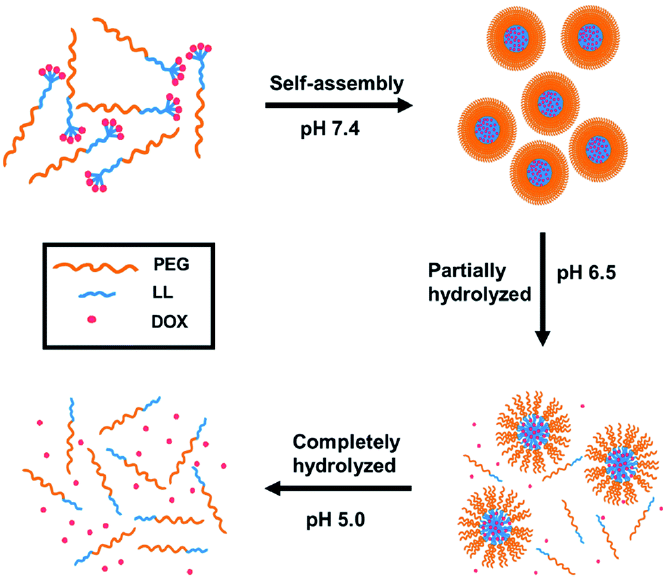
Figure 9. Schematic illustration of self-assembly and the low pH-triggered DOX release from the self-assembled prodrug micelle. Reprinted with permission from Ref. [34]. Copyright © 2016 The Royal Society of Chemistry.